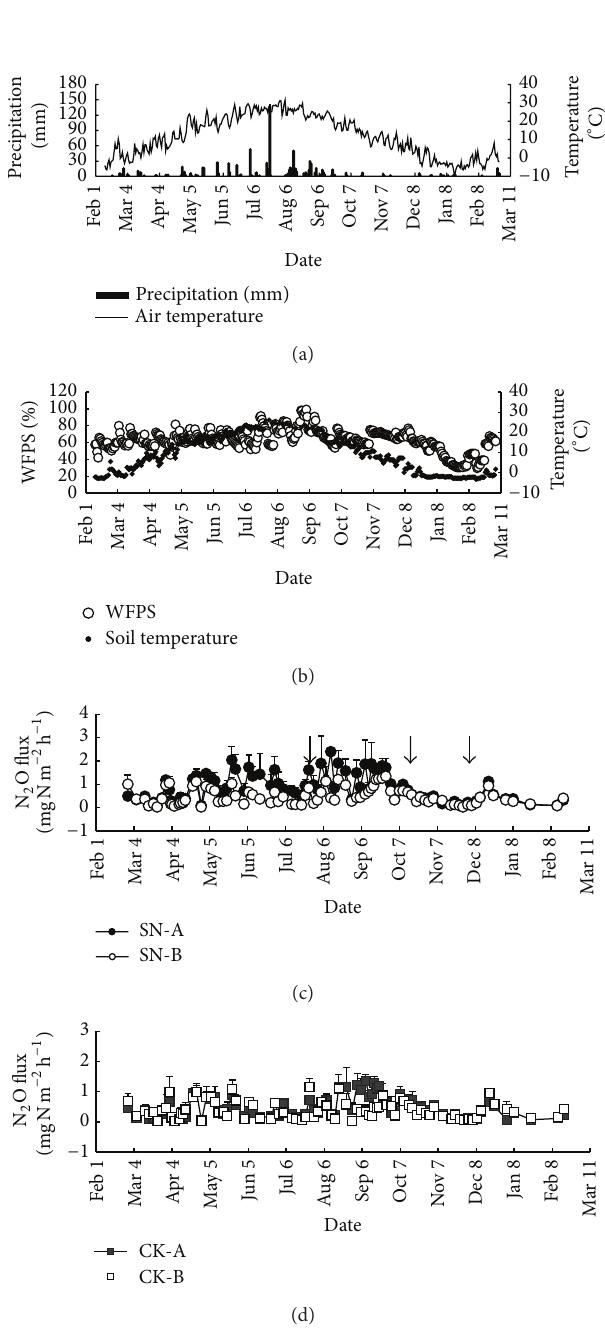
Figure 2: (a) Daily precipitation and average air temperature, (b) soil moisture (WFPS, i.e., the water-filled pore space) and soil temperature at 10cm depth in site A (under the middle of an apple tree canopy), (c) N 2 O fluxes from SN, and (d) N 2 O fluxes from CK. The N 2 O data are the means and standard errors (the vertical bars) of three replicates. SN-A means site A (the fertilization area in an apple tree canopy projection area) in SN treatment. SN-B means site B (the unfertilization area in an apple tree canopy projection area) in SN treatment. CK-A and CK-B mean sites A and B in CK treatment, respectively. The downward arrows indicate the time of fertilization.